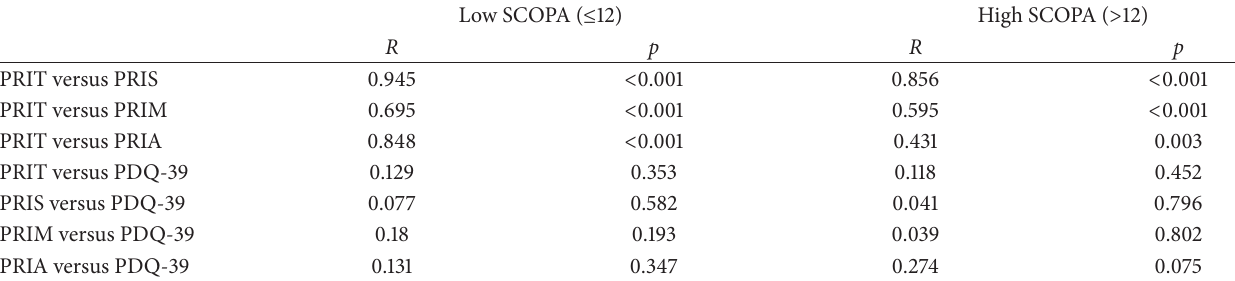
Table 3: Correlation coefficients among PRI (total), PRI (sensory, miscellaneous, or affective), and